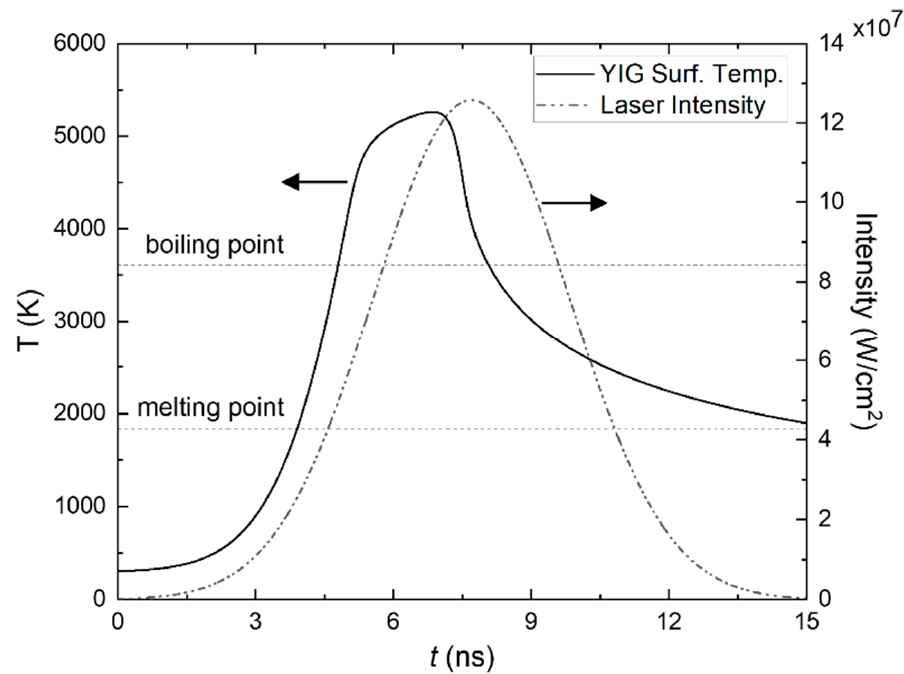
Figure 3. Effect of laser irradiance on the surface temperature of the YIG target. The left y -axis denotes the surface temperature ( T ), while the right y -axis denotes the intensity of laser, I ( t ) . T was calculated by numerically solving 1D heat conduction equations as expressed in the Equation (3) for temperatures under the melting point ( T ≤ T m ) and Equation (8) for T above the melting point ( T > T m ). γ = 1.2 and T P = 7000 K, resulting in maximum height of plume H max = 13.29 µ m, are used in the calculation. The numbers of partitions are M = 12,000 and N = 300.